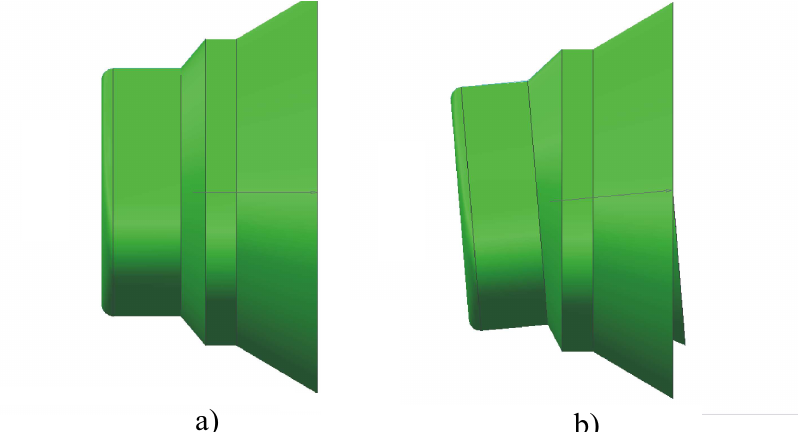
Figure 2. Nozzle block before ( a ) and after ( b ) rotation.